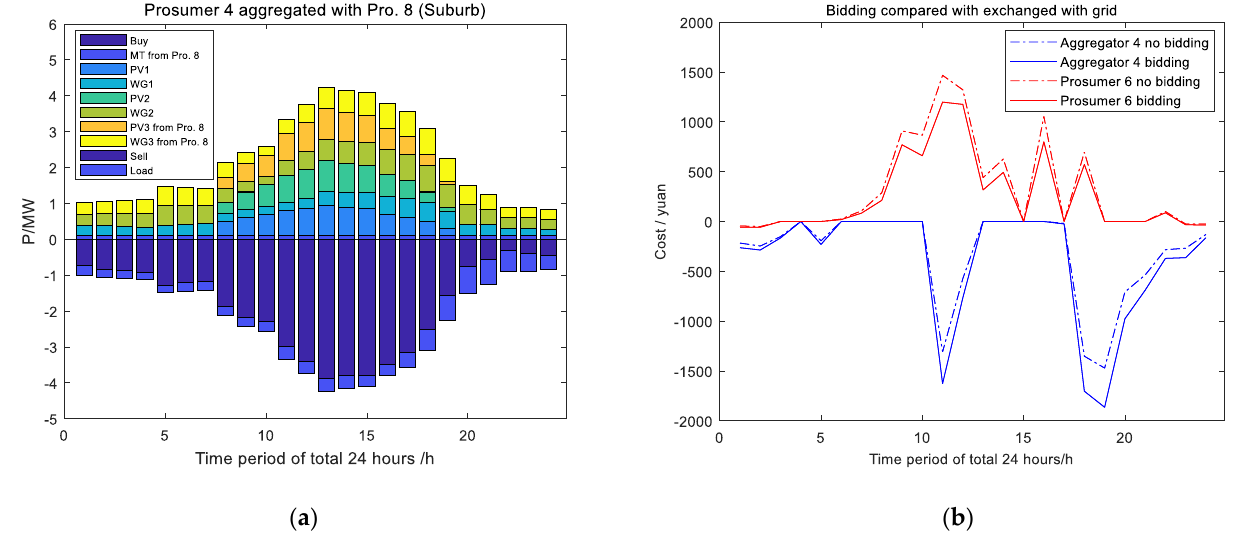
Figure 17. The bidding scenario for the first stage on the aggregator scenario. ( a ) Aggregator 4’ s optimization solution; ( b ) Bidding compared with no bidding of user 4 and 6.